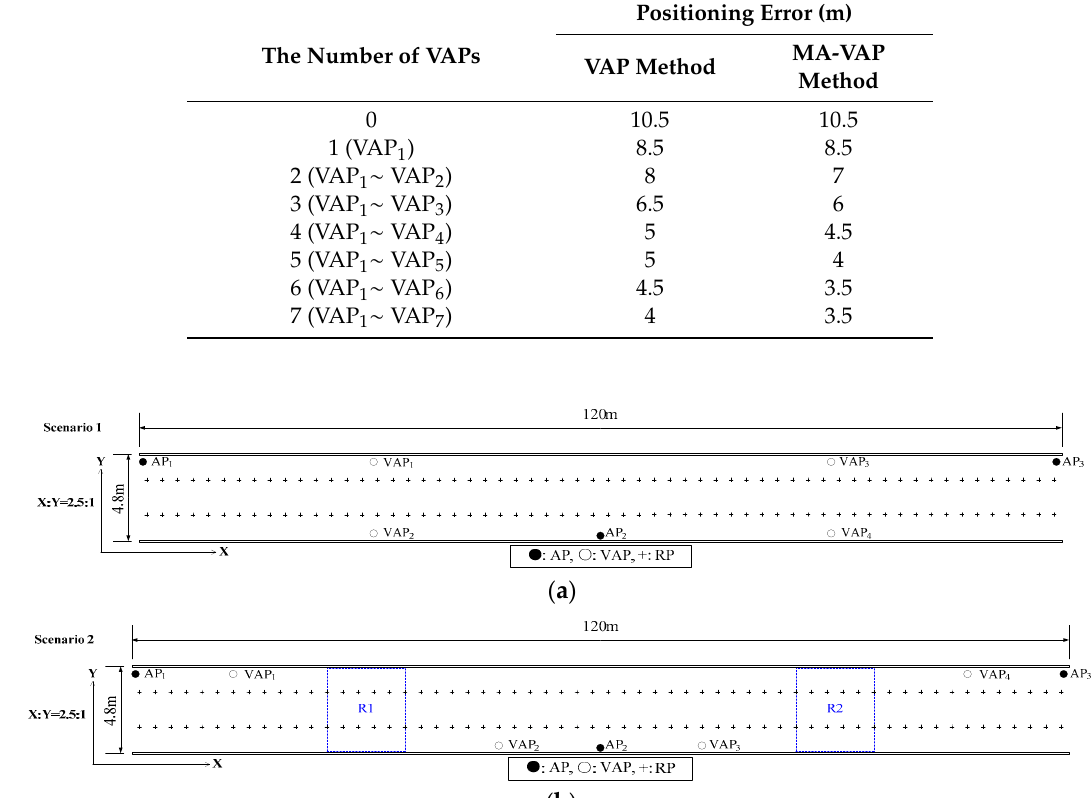
and di ff erent locations of VAPs: ( a ) Scenario 1; ( b ) Scenario 2; ( c ) Scenario and different locations of VAPs: ( a ) Scenario 1; ( b ) Scenario 2; ( c ) Scenario 3.